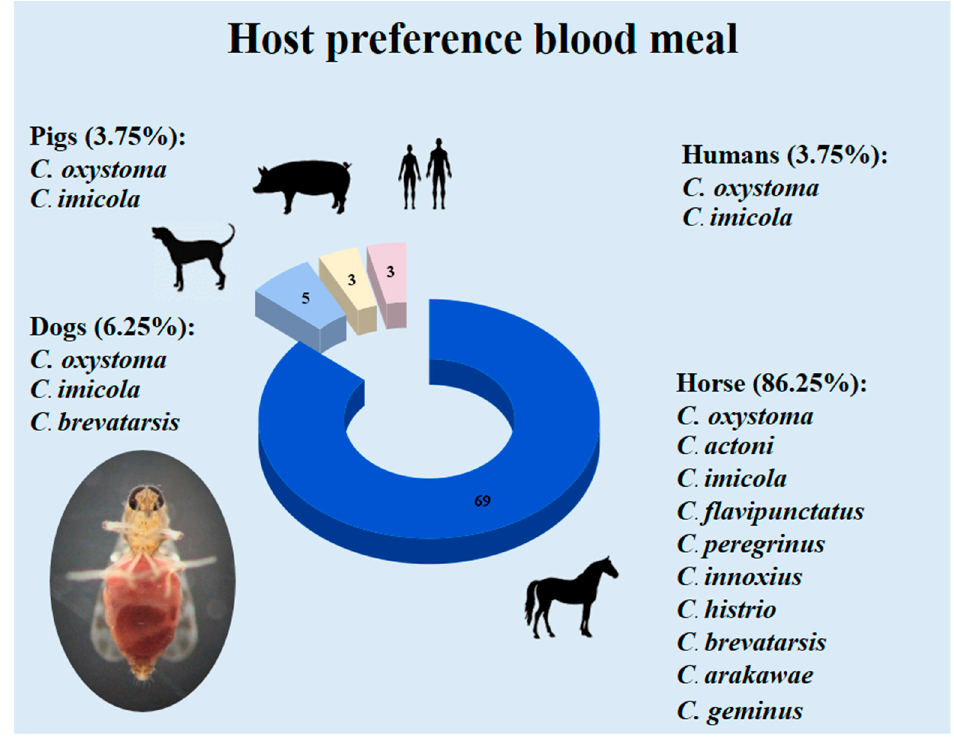
Figure 5. Host preference blood meal of the Culicoides species collected in horse farms in Hua Hin district, Prachuab Khiri Khan province, Thailand. Numbers in the pie chart are indicating number of Culicoides that feeding on each host blood meal.